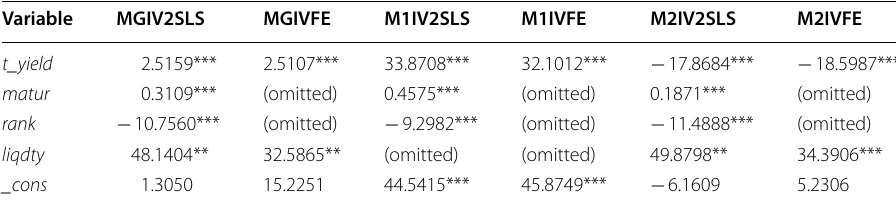
Table 3 Regression